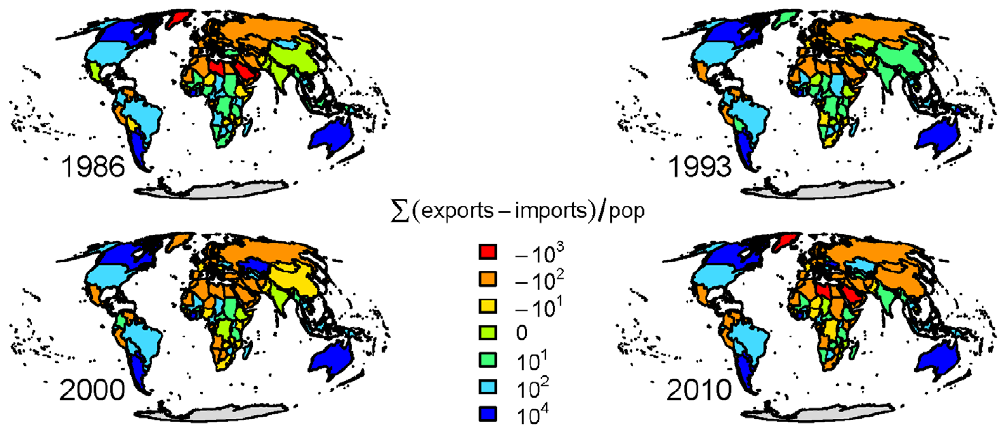
Figure 2. The virtual water import-export balance m 3 per capita for the years 1986, 1993, 2000 and 2010.